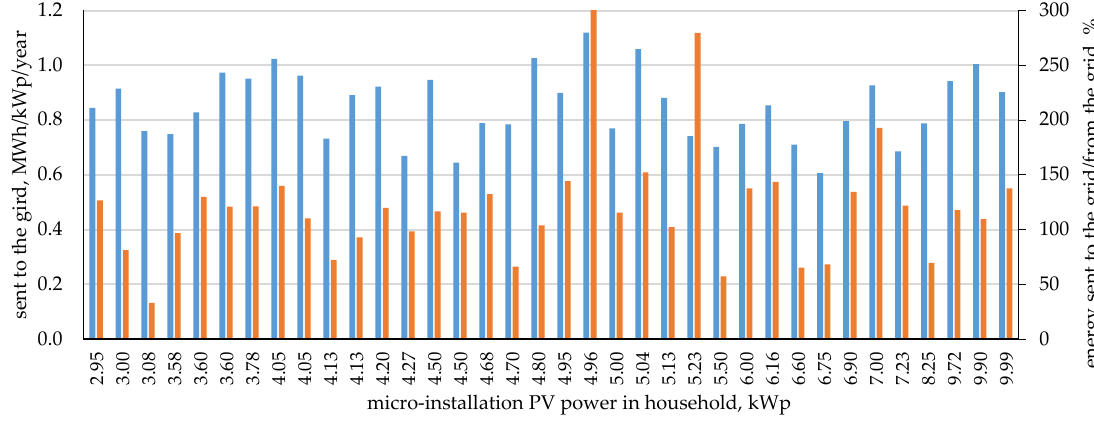
Figure 2. Annual values of energy sent to the grid in relation to the installed capacity and the annual share of energy sent to the grid in relation to the consumed, in the Lesser Poland province 1 June 2019–31 May 2020. Source own study based on